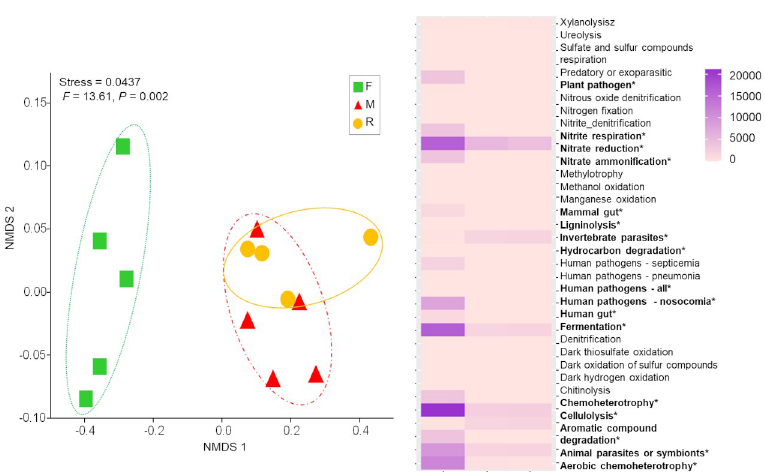
Fig 5. Bacterial functional groups composition. Non-metric multidimensional scaling (NMDS) ordination of bacterial functional groups under three different treatments, square: forest (F), triangle: mine (M) and circle: young mine-rehabilitation (R), based on Bray-Curtis distance. Heat-map showing the percentage of OTU abundance for individual function.